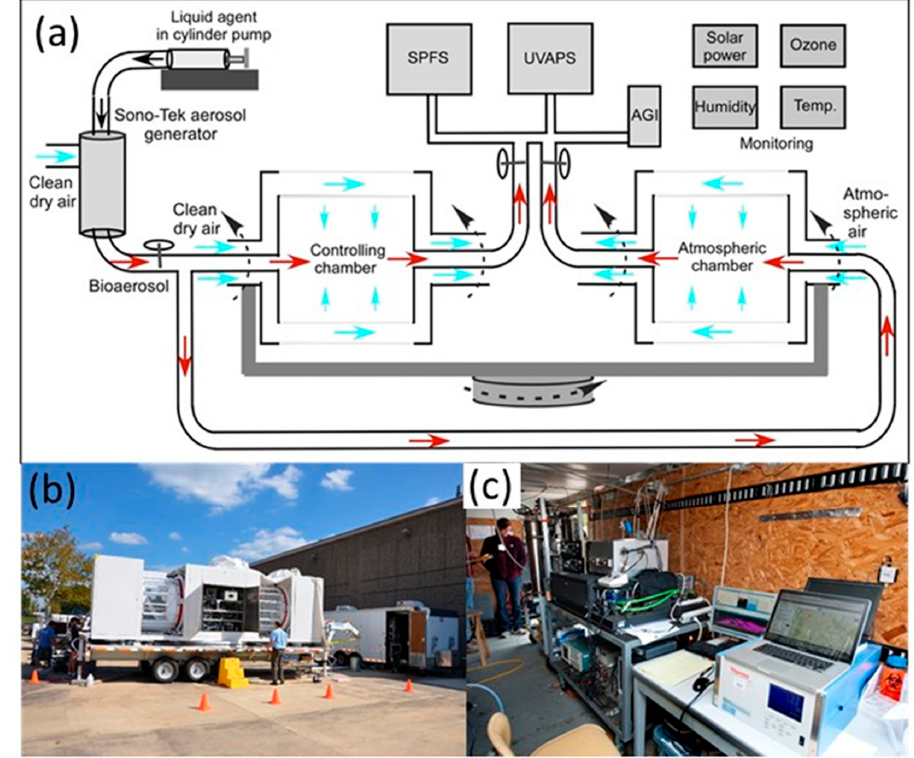
Figure 1. ( a ) Diagram (top) and ( b ) photographs (bottom left) of the Captive Aerosol Growth and Evolution (CAGE) chamber system used in this study. ( c ) The aerosol generator, the single-particle fluorescence spectrometer (SPFS), the ozone analyzer, and the precision spectral pyronometer, etc. controlling and measuring devices (the bottom right photograph) within the truck trailer sitting at the right side of the bottom left photograph.